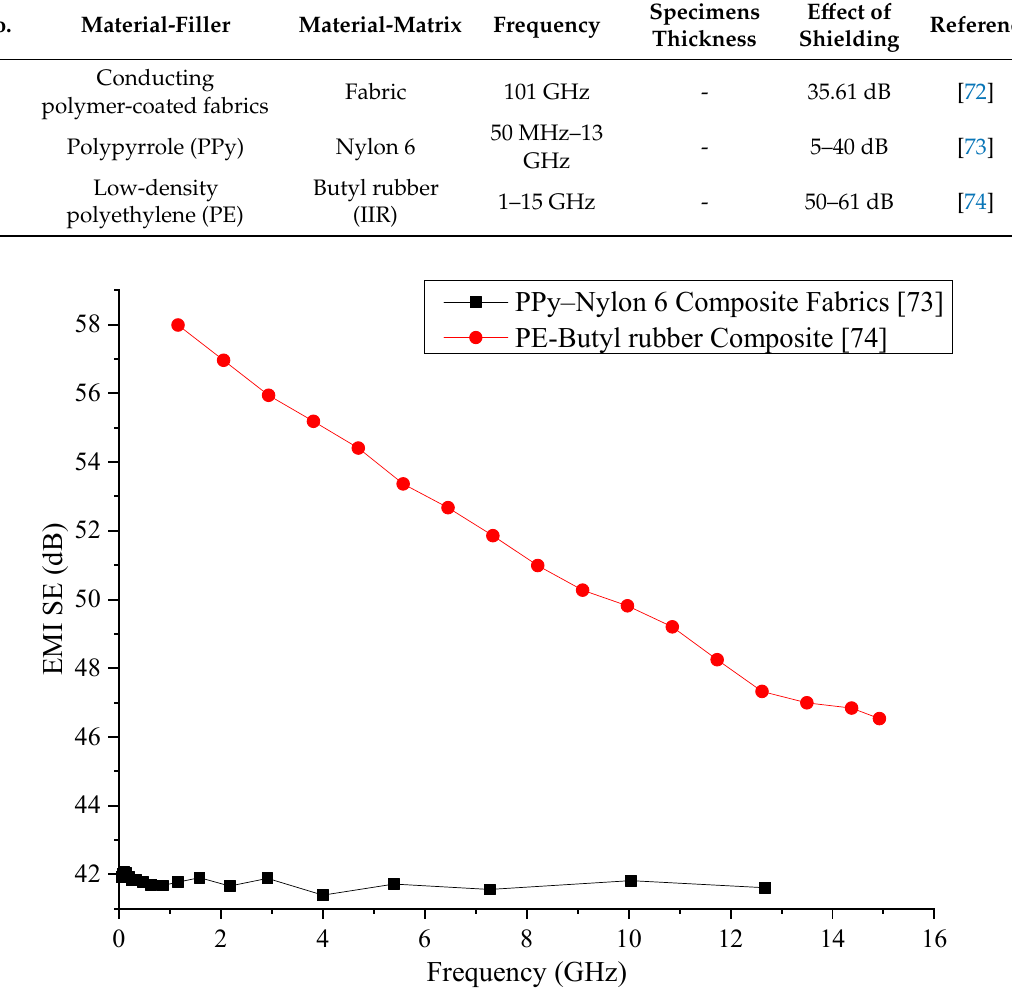
Table 1. Summary of electrically conductive EMI shielding polymer composites.